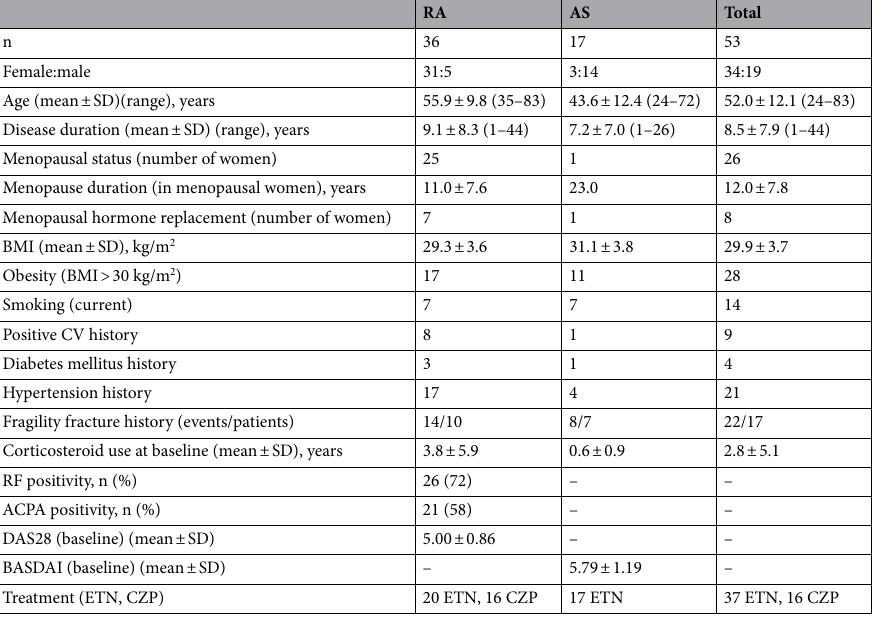
Table 1. Patient characteristics. ACPA , anti-citrullinated protein antibody, AS , ankylosing spondylitis, BASDAI Bath ankylosing spondylitis disease activity score, BMI body mass index, CV cardiovascular,